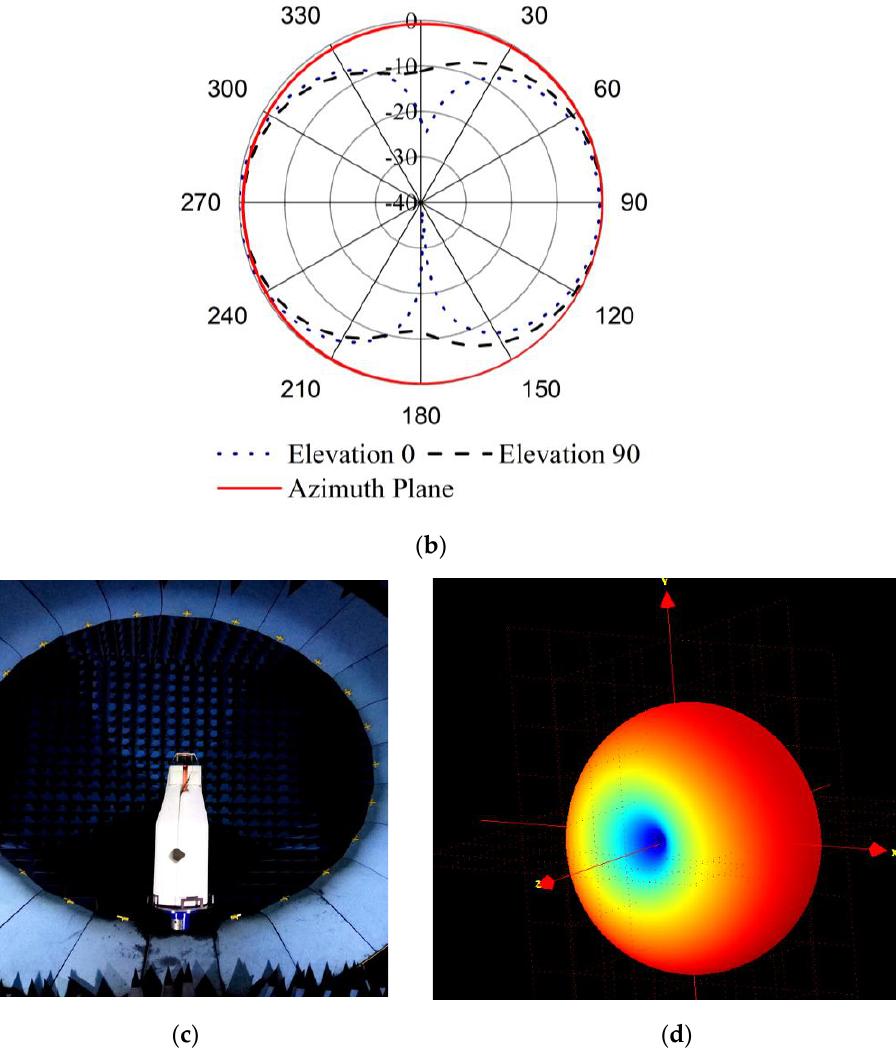
Figure 4. Antenna radiation pattern with satellite structure — ( a ) simulated 3D radiation pattern, ( b ) 2D radiation pattern ( c ) measurement setup and ( d ) measured radiation pattern.